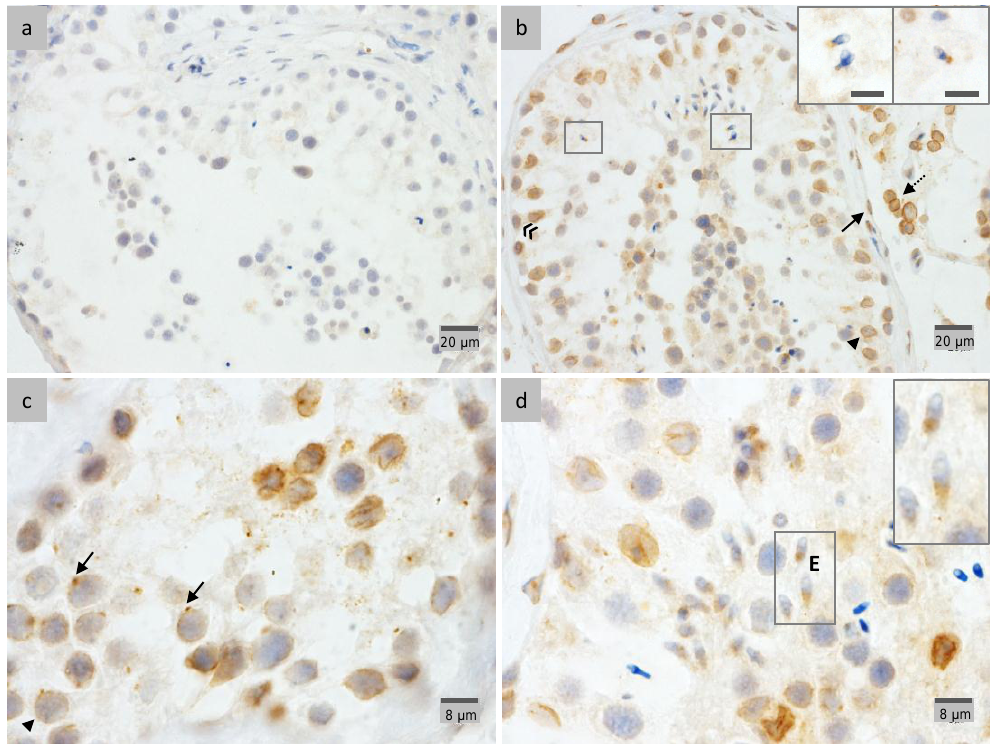
Figure 2. Immunohistochemical localization of LAP1 in human testis sections fixed in 4% PFA. Positive immunostaining appears in brown color and nucleus counterstaining with hematoxylin. ( a ) Negative controls with rabbit IgG showed no LAP1 staining. ( b ) LAP1 is present in the NE of peritubular (arrow), Leydig (dotted arrow) and Sertoli (arrowhead) cells, as well as spermatogonia (double arrowhead). Additionally, LAP1 is found in mature spermatids at the centriolar pole (ROIs, scale bar: 8 µ m). ( c ) LAP1 staining is also evident in the NE of spermatocytes and in a dot juxtaposed with the nucleus (arrows). ( d ) LAP1 polarizes at the centriolar pole of elongating spermatids (E), which is concomitant with nuclear reshaping and chromatin condensation. LAP1: lamina-associated polypeptide 1; PFA: paraformaldehyde; NE: nuclear envelope; ROI: region of interest.